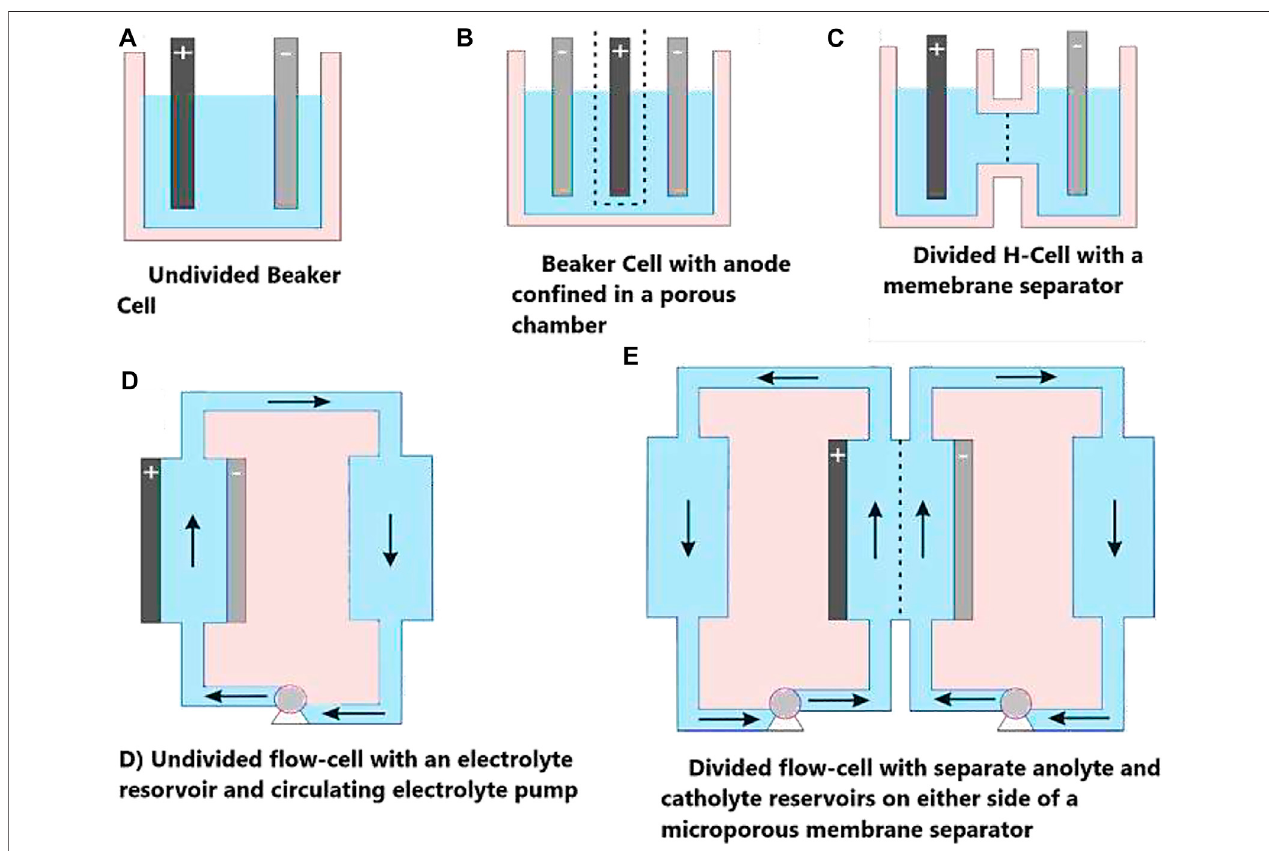
FIGURE 3 | Commonly employed laboratory-scale electrochemical cells, where the solid arrows indicate the direction of electrolyte fl ow and dashed arrows indicate a porous separator or ion conductive membrane. Adopted with permission from Perry et al. (2020).